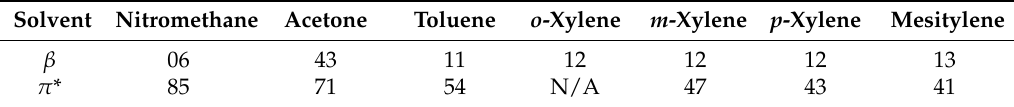
Table 5. Values of the hydrogen-bond-acceptance (HBA) ability β and polarity/polarizability π *